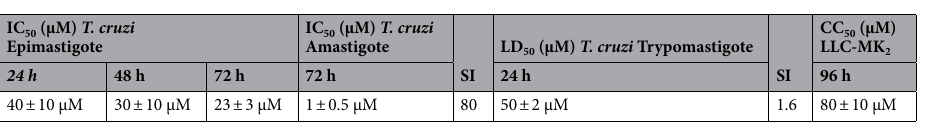
Table 1. Analysis of cytotoxicity and trypanocidal effect of FEX. IC 50 : concentration that inhibits 50% of the proliferation of the replicative form. LD 50 : concentration that causes lysis in 50% of the trypomastigotes. CC 50 : concentration that inhibits the proliferation of host cells by 50%. SI: selectivity